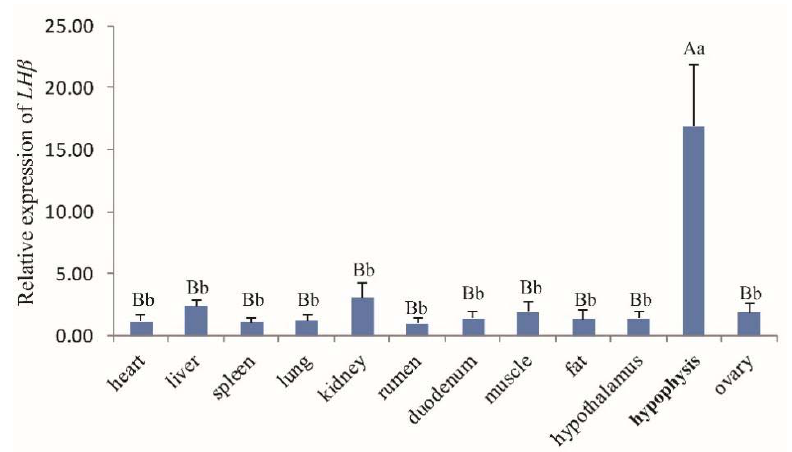
Figure 2. The LH β mRNA expression profile of various tissues in Hu rams. Note: Different capital letters indicate an extremely significant difference ( p < 0.01), and different lowercase letters indicate a significant difference ( p < 0.05).